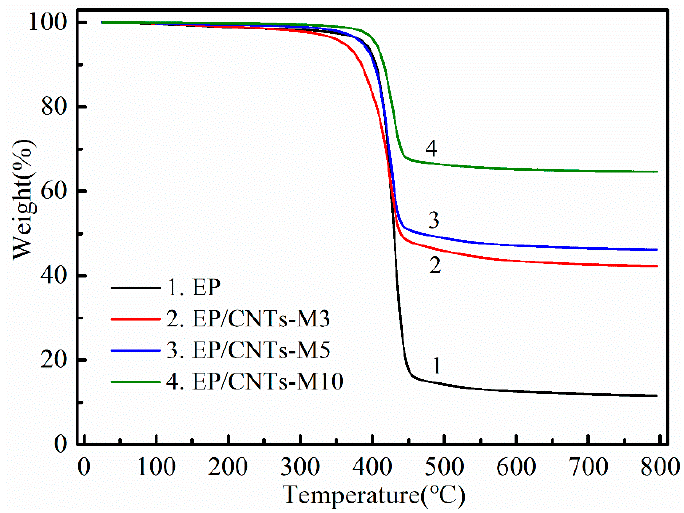
Figure 5. TGA curves of EP, EP/CNTs-M3, EP/CNTs-M5 and EP/CNTs-M10.